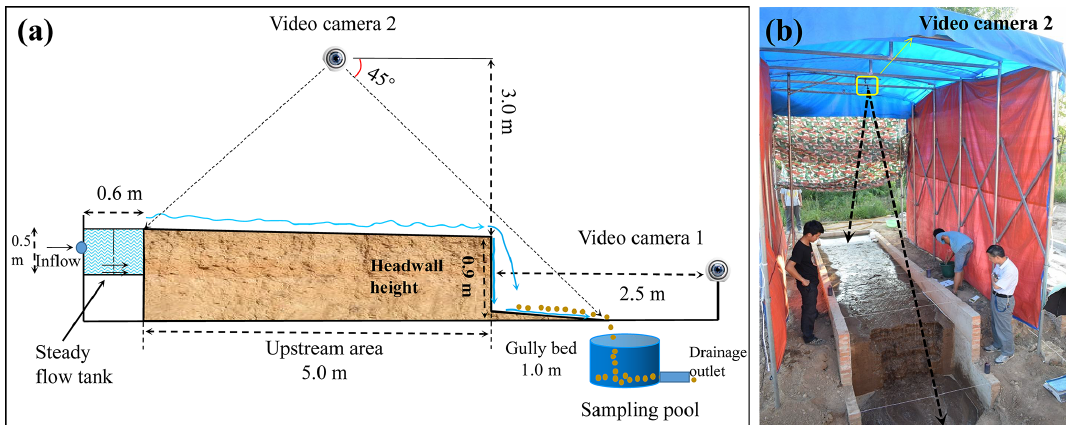
Figure 1. Sketch (a) and photo (b) of experimental